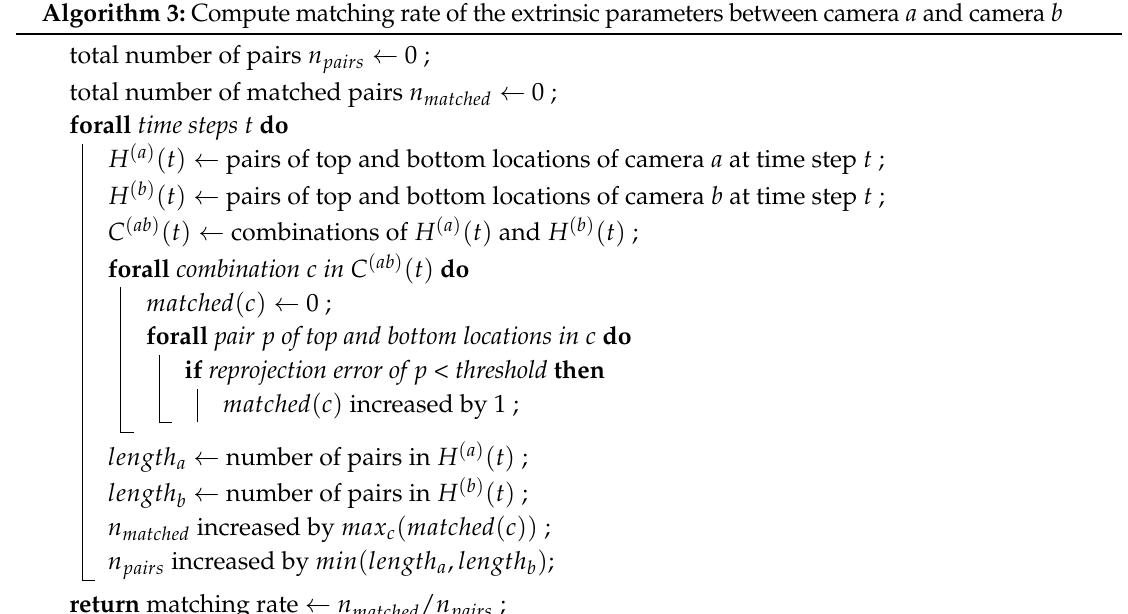
Algorithm 3: Compute matching rate of the extrinsic parameters between camera a and camera